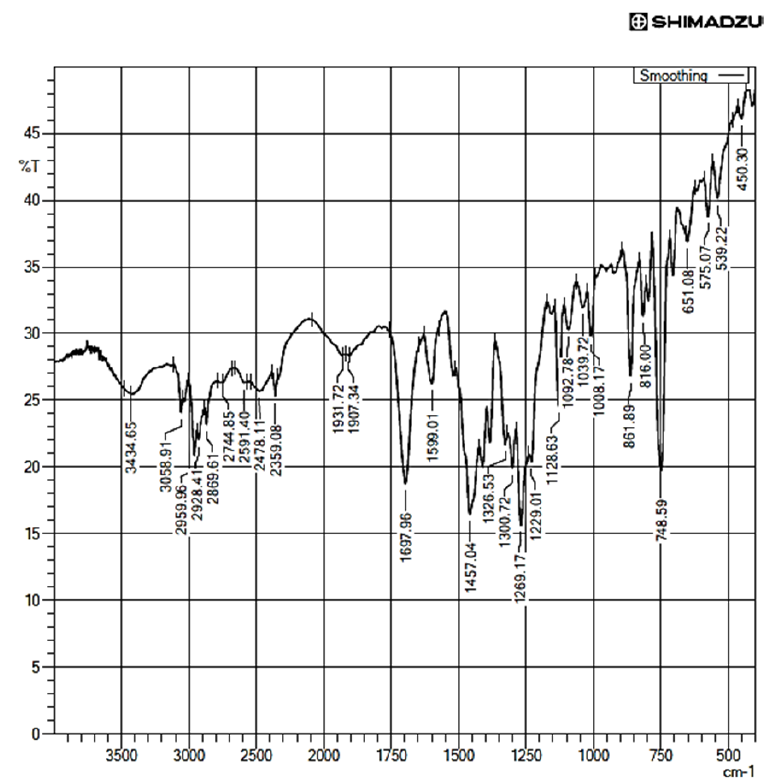
Figure 12. FT-IR spectra of Pure Telmisartan. Pharmaceuticals 2023 , 16 , x FOR PEER REVIEW For maleic acid FT-IR spectra (Figure 13), the band at 3058 cm −1 depicts the charac- teristic C-H stretch of – C=C – the backbone of maleic acid; the peak at 1708 cm −1 depicts the characteristic C=O stretch of – COOH; and the peaks at 1432.66 cm −1 and 1464.21 cm −1 suggest the – OH bend of the carboxylic acid groups of maleic acid. The 1262.00 cm −1 and 1218.98 cm −1 peaks are the characteristic – C=O stretch of two carboxylic groups of maleic acid. The 1708 cm −1 and 1620 cm-1 peaks denote the – C=O vibrations of the two carbox- ylic acids in maleic acid.